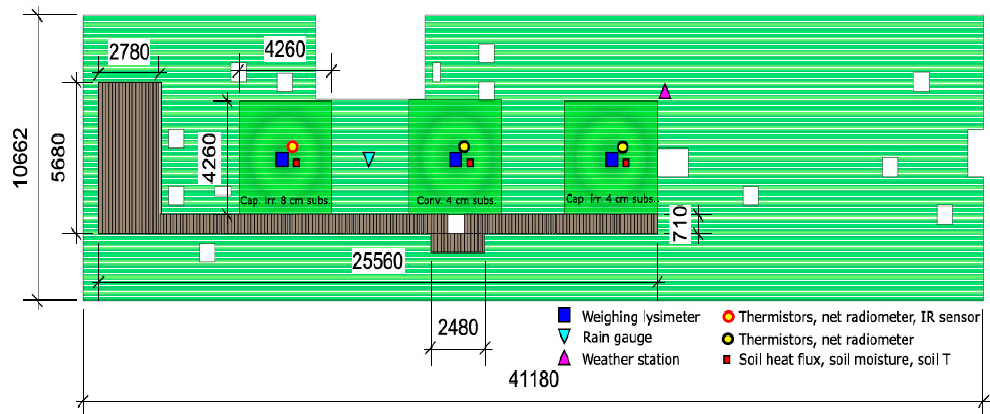
Figure 1. Top view of the three research plots (green squares) and locations of the different sensors. Distances are in mm. In brown is the inspection floor.